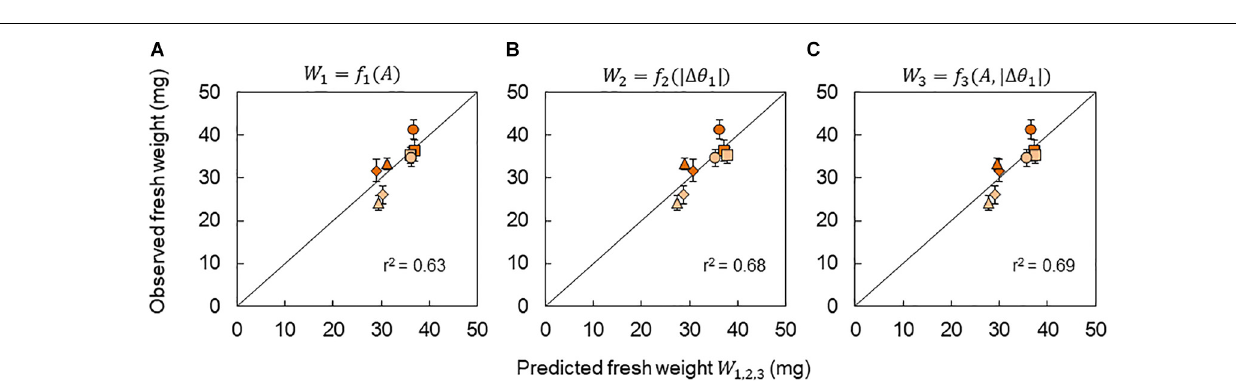
FIGURE 7 | Prediction of fresh weight based on the CCA1 rhythms. Correlation between observed fresh weight and predicted fresh weight using models W 1 = f 1 ( A ) (A) , W 2 = f 2 (| (cid:49) θ 1 |) (B) , and W 3 = f 3 ( A , | (cid:49) θ 1 |) (C) . The value of r 2 indicates the coefficient of determination for the line with a slope of 1. Symbols indicate the same conditions as shown in Figure 6